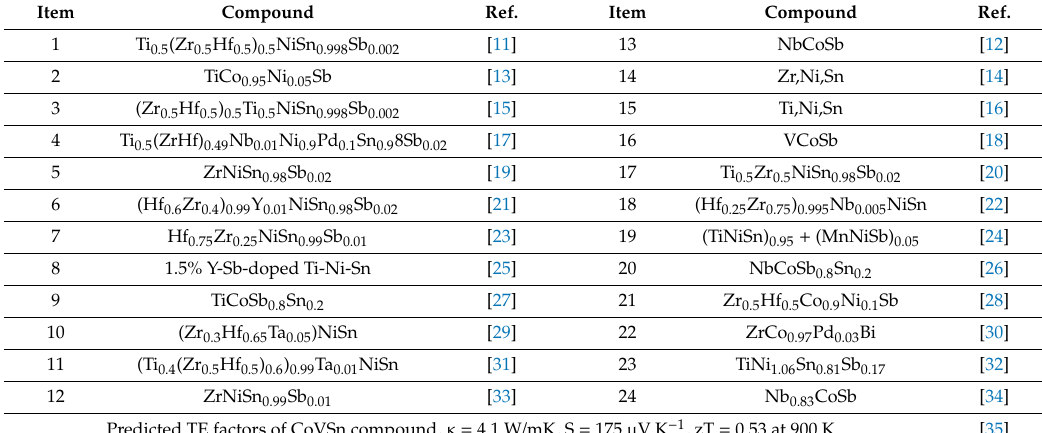
calculations. Figure 2 shows the calculated electronic band structure and density of states (DOS) of CoVSn alloy [38]. Based on this electronic structure, the alloy was predicted as a p-type semiconductor with a bandgap (W-X) of 0.85